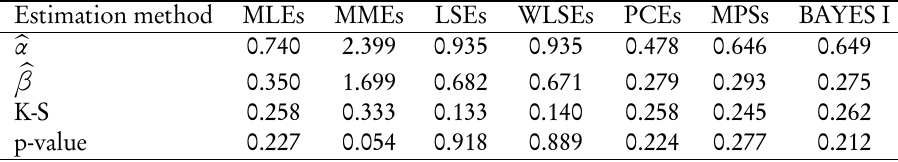
Estimates, K-S distances and corresponding p-values based on different estimates for Example 1.